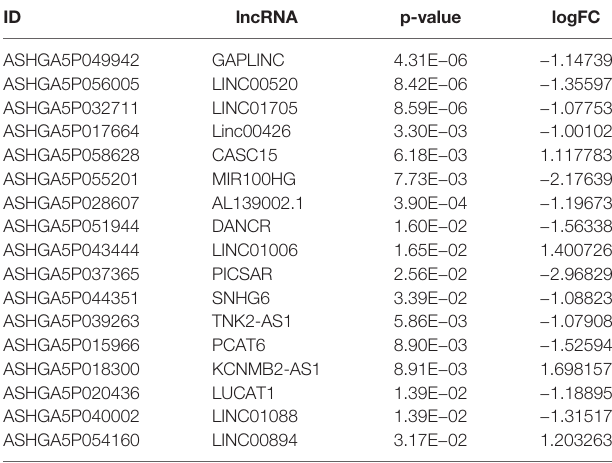
TABLE 3 | The 17 lncRNAs identi fi ed and their